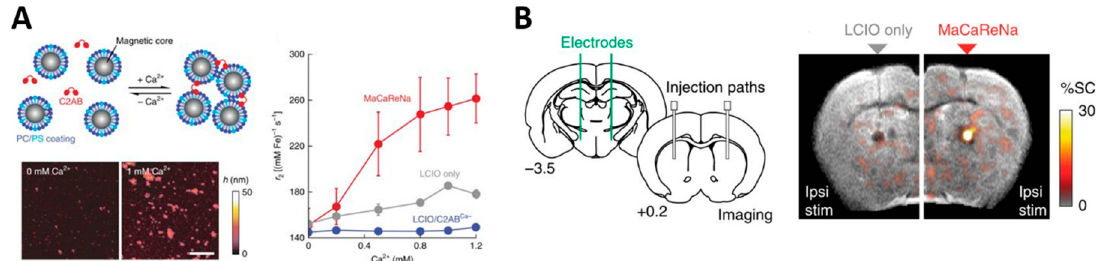
Figure 7. ( A ) Schematic of the sensor design based on lipid-coated iron oxide nanoparticles (LCIOs) and C2AB (top left) and the AFM of MaCaReNas imaged after exposure to 0 or 1 mM Ca 2+ (bottom left). Titration curves showing r 2 values as a function of [Ca 2+ ] in aCSF, indicating MaCaReNa responsiveness to calcium concentrations characteristic of the brain extracellular space. LCIOs alone (grey) or in the presence of C2AB Ca − (blue) display little responsiveness to Ca 2+ . ( B ) MFB electrode implantation and striatal MaCaReNa infusion Ipsilateral (ipsi) MFB stimulation (stim) induces MRI signal changes in the presence of MaCaReNas (right), but not of control LCIO particles (left). Adapted with permission from [61]. Copyright © 2018, Springer Nature.